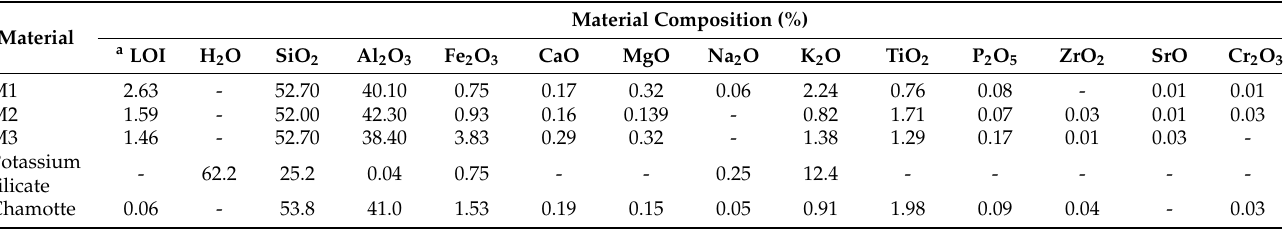
Table 1. Chemical composition (wt. %) of raw materials.